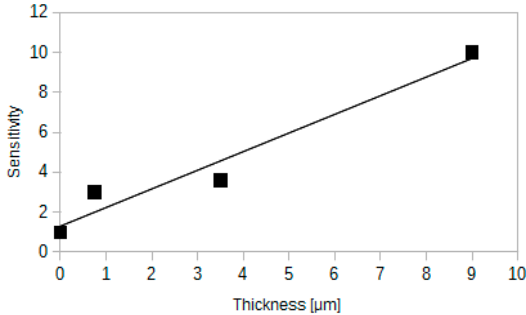
Figure 6. The influence of a sensing layer thickness on the sensitivity. Measurements have been performed on scanning electron microscope.